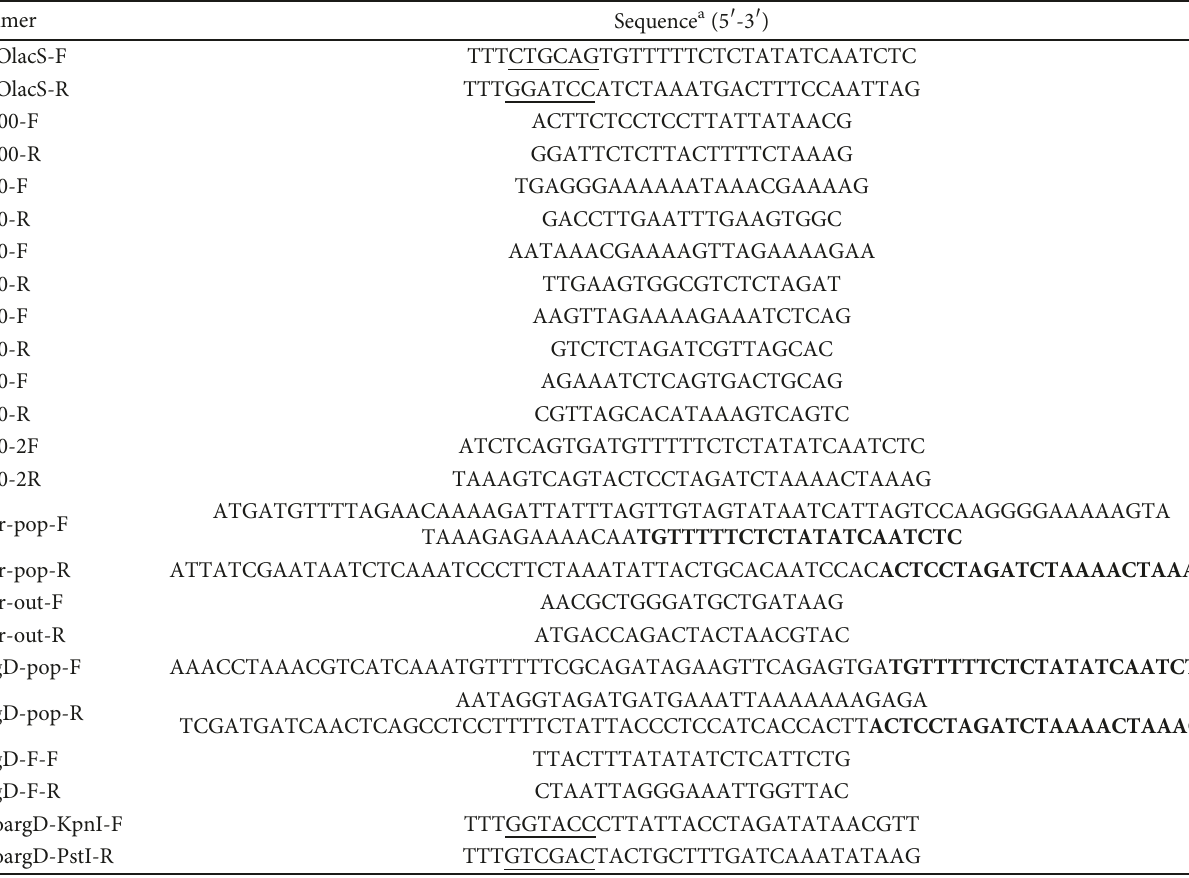
Table 2: Primers used in this